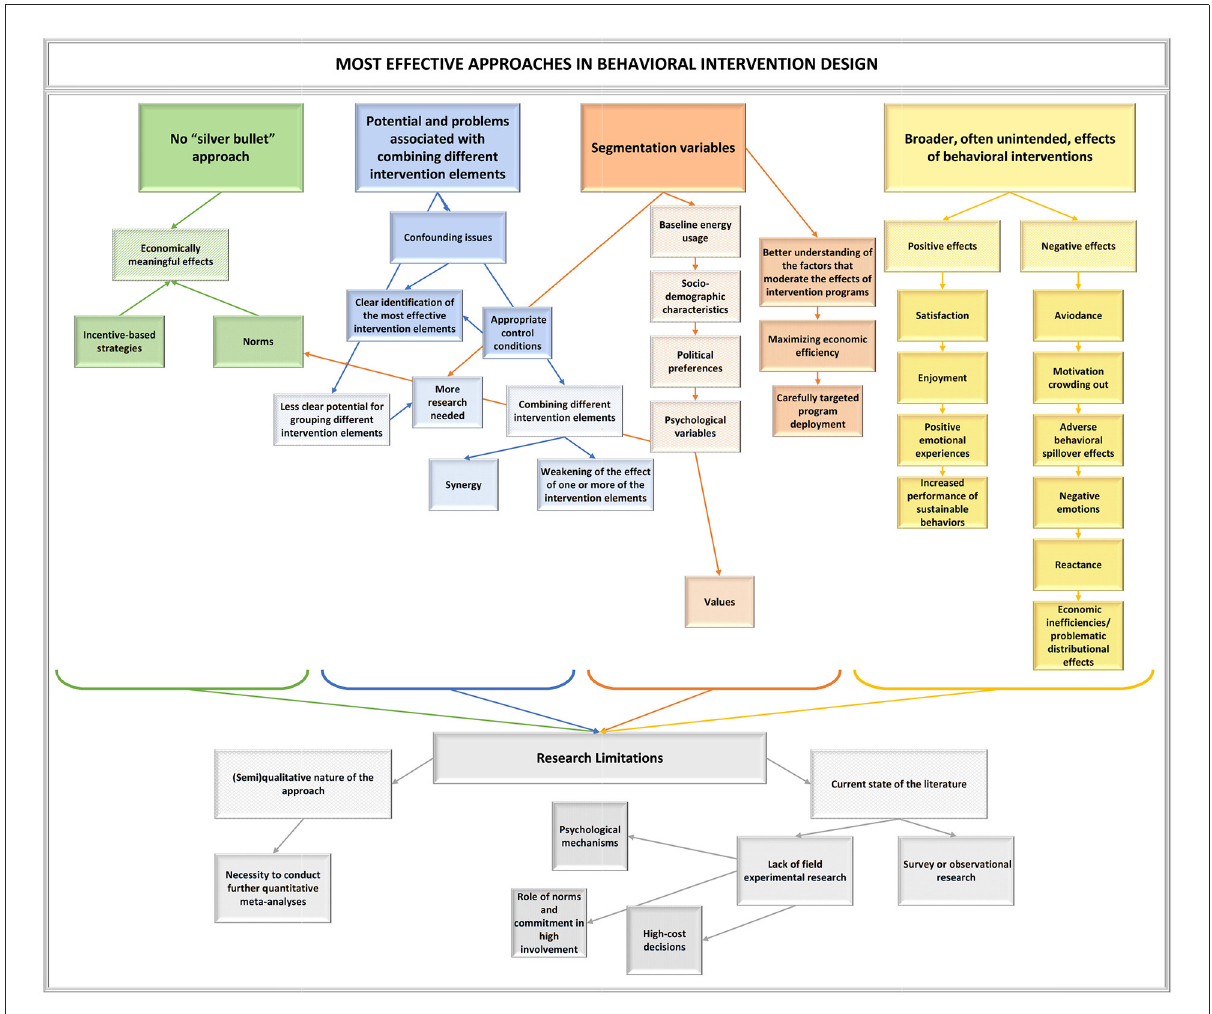
FIGURE2 Overview of general